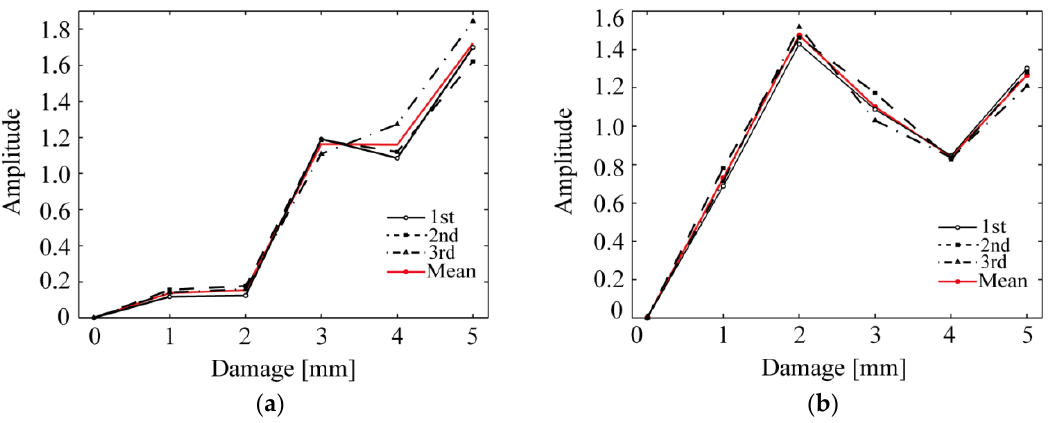
Figure 10. Damage assessment. ( a ) Tendency of normalized amplitudes of defect echoes of mode L ( 0,1 ) versus damage size; ( b ) Tendency of normalized amplitudes of defect echoes of mode L ( 0,2 ) versus damage size.